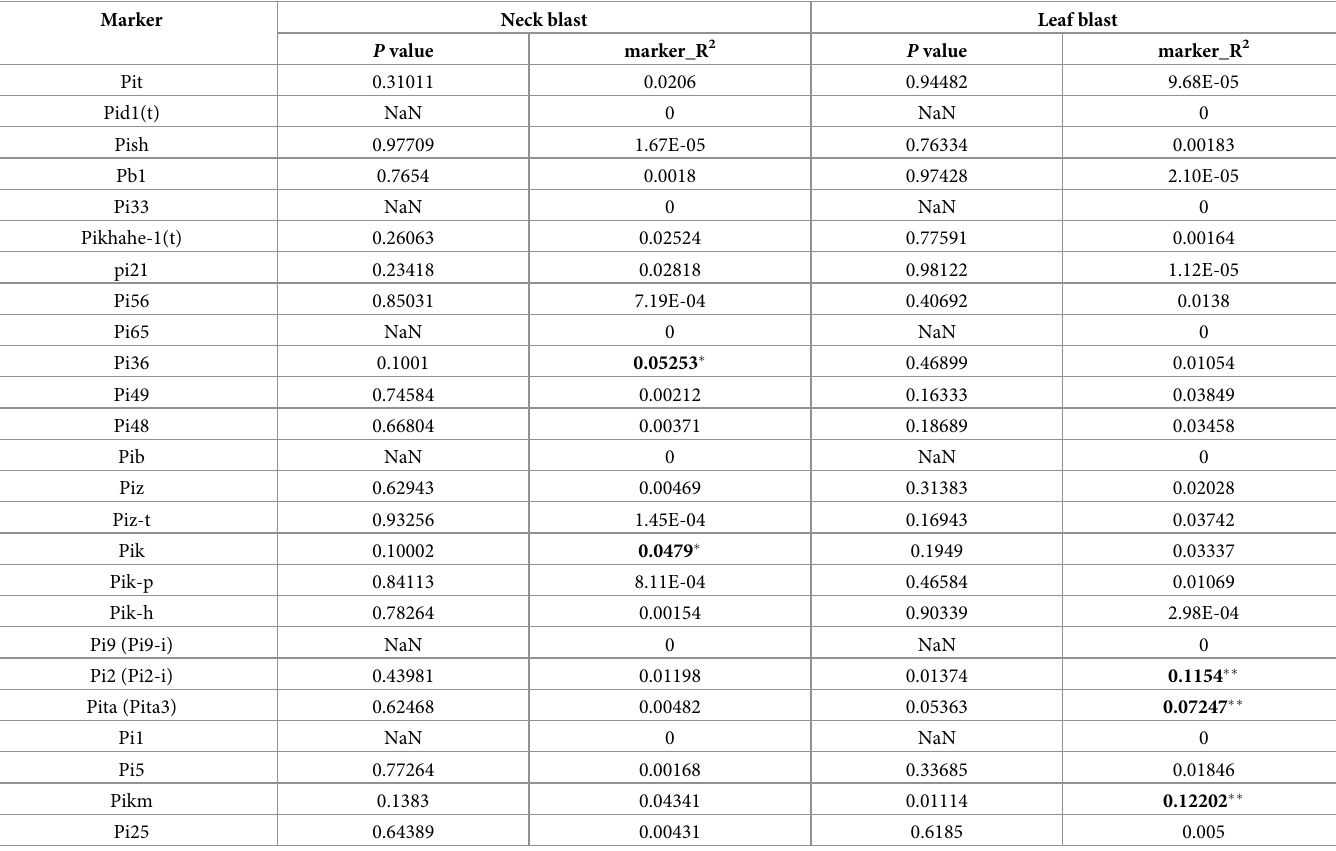
Table 5. Genetic association of blast resistant genes with rice neck and leaf blast disease in 52 genotypes.